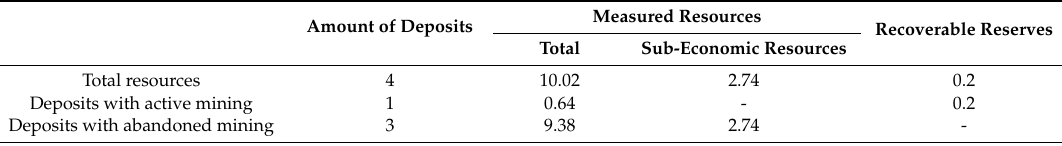
Table 2. Diatomaceous earth resources of Poland (Mt)